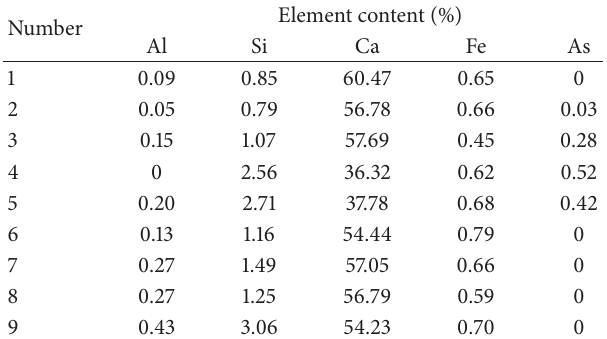
Table 3: EPMA point analysis data of CH crystal in cement paste.